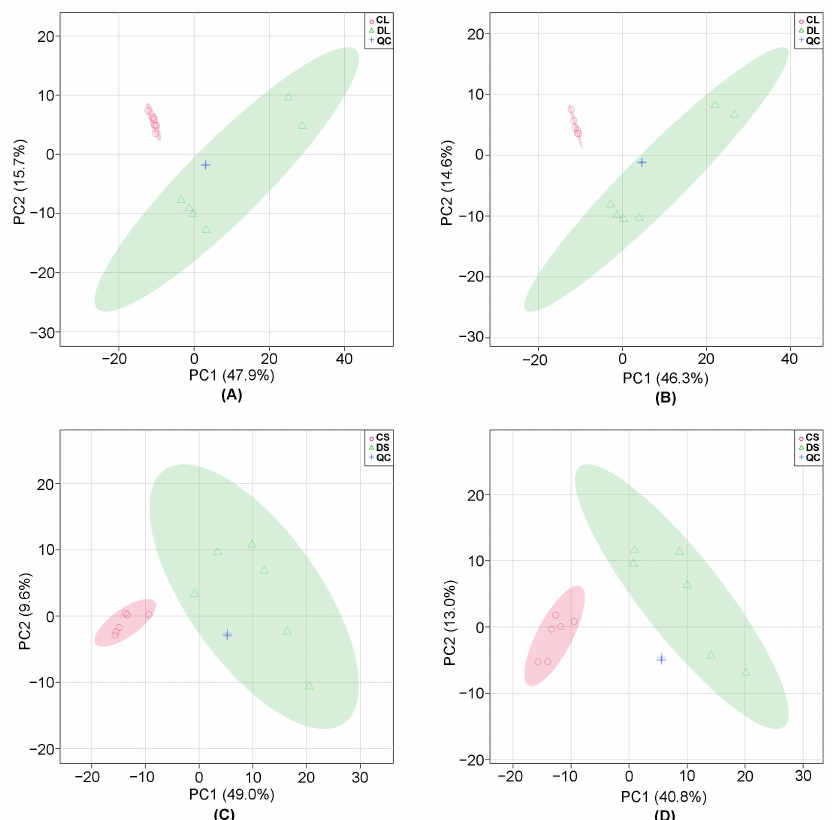
Figure 1. Principal component analysis (PCA) scores plot of ginseng leave samples and ginseng stem samples in the negative ion mode ( A , C ) and positive ion mode ( B , D ), respectively. CL: control leave group; DL: diseased leave group; CS: control stem group; DS: diseased stem group; QC: quality control.